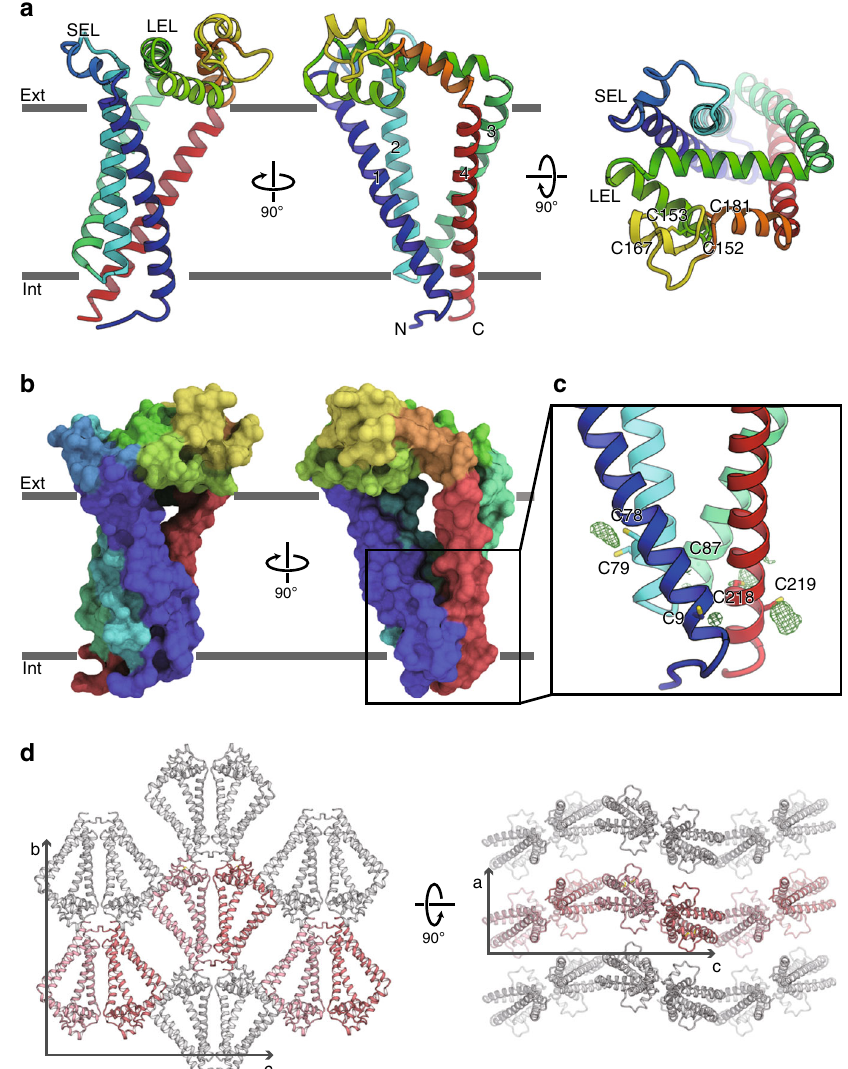
Fig. 1 Crystal structure of human CD9. a Overall structure of human CD9, viewed from the membrane plane (left and middle) and from the extracellular side (right). The transmembrane helices and the two extracellular loops (SEL and LEL) are labeled. Cys152-Cys181 and Cys153-Cys167 form disul fi de bonds. b Surface representation of CD9, colored according to a . c Palmitoylation of the cytoplasmic cysteine residues. Green meshes show F o − F c densities contoured at 2.5 σ , indicating the palmitoylation of the cysteine residues on the cytoplasmic end of the four transmembrane helices. d Crystal packing of CD9, showing the curvature generation by the asymmetric shape of the CD9 molecules. Pairs of CD9 protomers are aligned up and down alternatively along the c -axis, resulting in the wavy lipid layers of the LCP